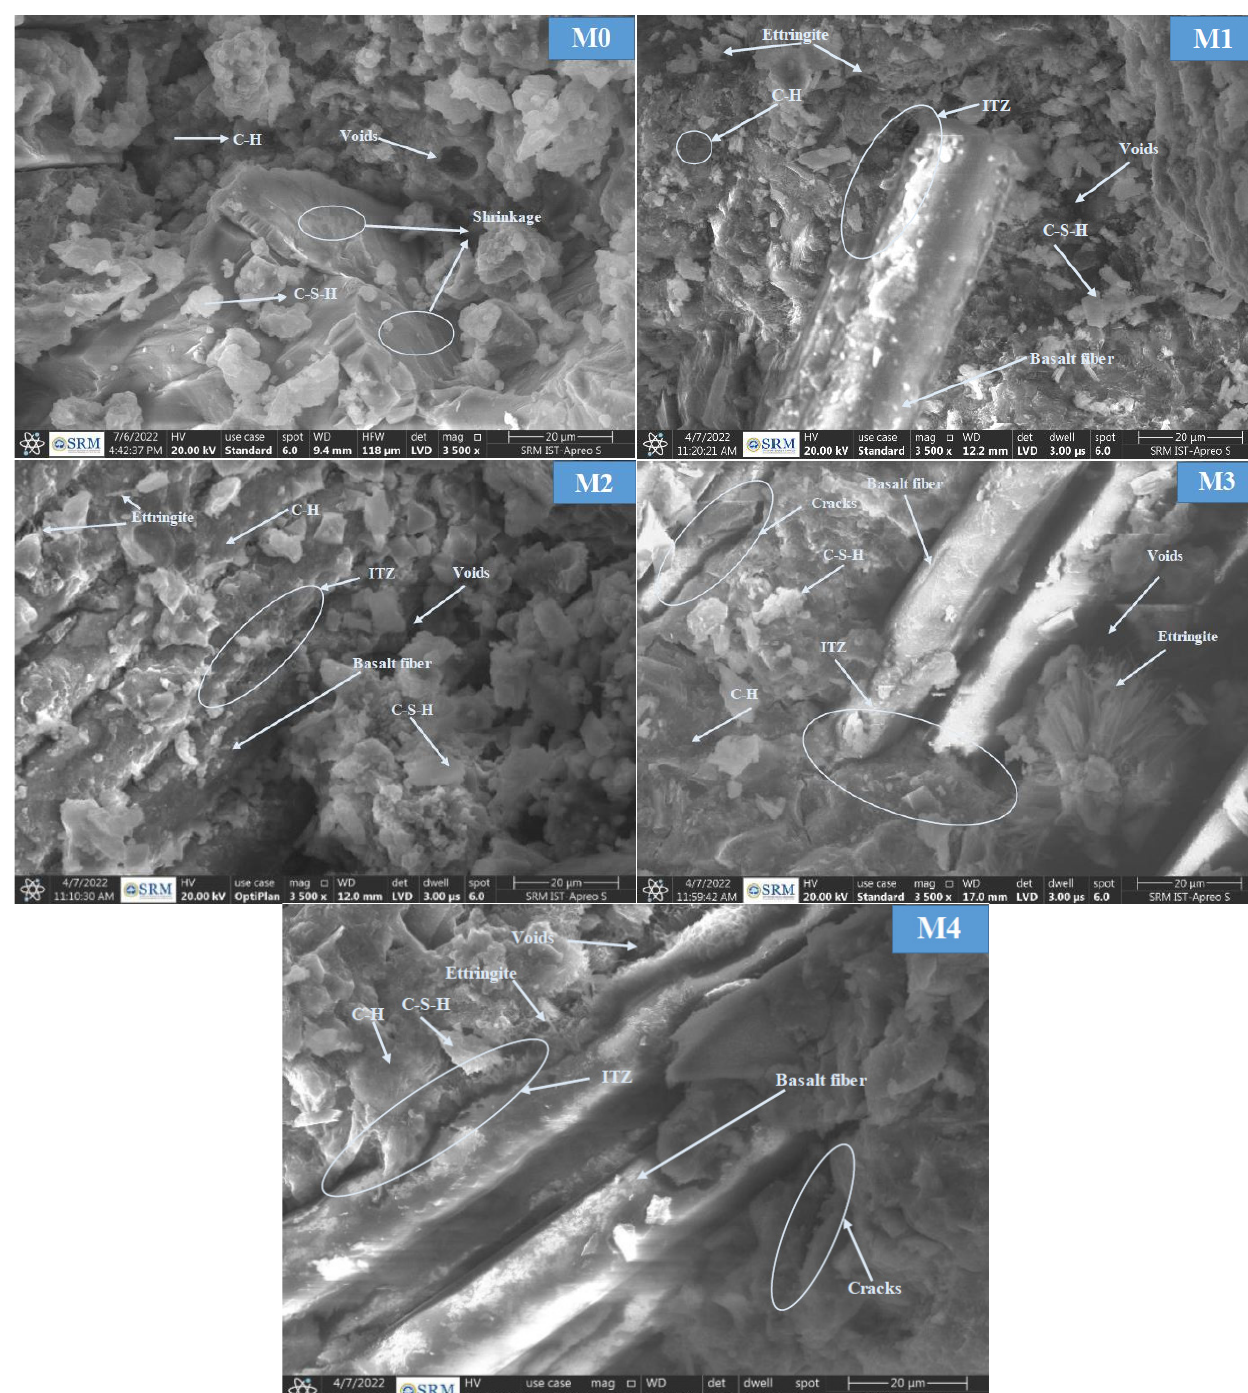
Figure 8. SEM Analysis of BFRFGC for five different